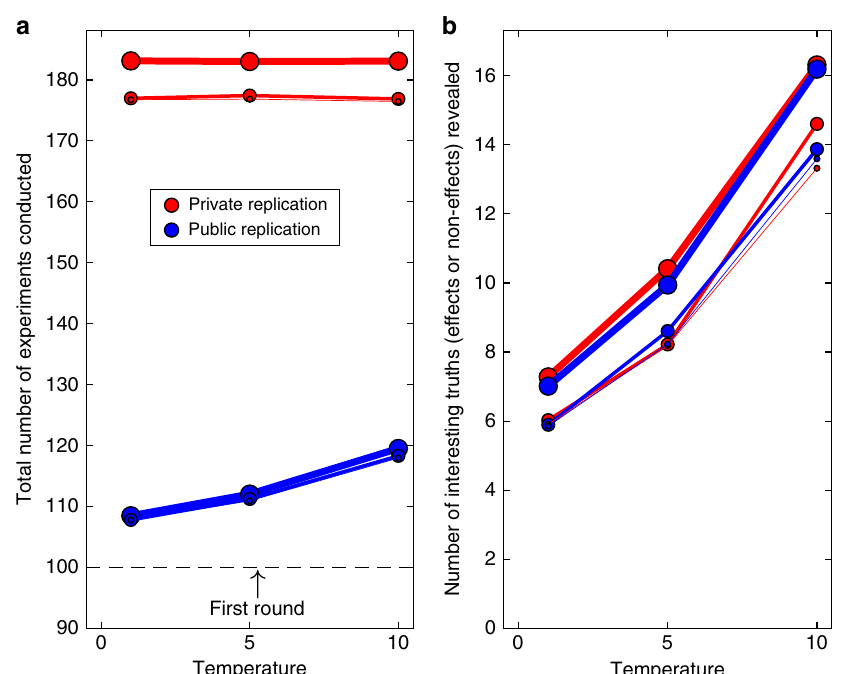
Fig. 8 Scienti fi c achievements and costs for theory-testing research, using a symmetrical Bayesian approach. Tests are conducted for the presence ( BF 10 > 3) as well as absence ( BF 01 > 3) of effects. a shows the cost (total number of experiments conducted) to generate the knowledge (true effects and true absences of effects discovered) in b . Because both presence and absence of an effect are considered, the maximum discoverable number of true outcomes is 100. In both panels, the thickness of lines and size of plotting symbols indicates the value of ρ , which captures overlap between the theory and reality. In increasing order of thickness, ρ was 0.1, 0.5, and 1.0. Temperature refers to the temperature of the logistic decision function (Methods Figure 9c, d explores the consequences of an optional stopping rule, another common variant of p -hacking. This practice involves repeated testing of additional participants, if a desired effect has failed to reach signi fi cance with the initial sample. If this process is repeated suf fi ciently often, a signi fi cant outcome is guaranteed even if the null hypothesis is true 10 . We instantiated 2 f 1 ; 5 ; 10 g additional the optional stopping rule by adding N ph participants, if an effect had not reached signi fi cance with the initial sample. This continued for a maximum of fi ve additional batches or until signi fi cance had been reached. Optional stopping had little effect on the basic pattern of results, including the although persistent testing of additional participants, as expected, represent true effects. Overall, Fig. 9 con fi rms that our principal engages in questionable research practices.